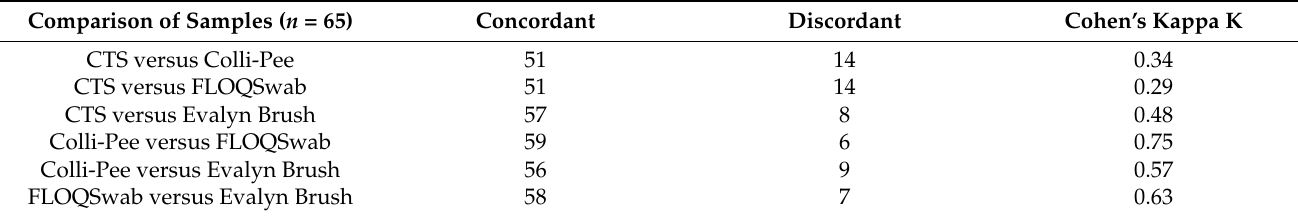
Table 4. Agreement on HPV positivity in clinician-taken smear (CTS), self-collected urine samples (Colli-Pee), FLOQSwab and Evalyn Brush.